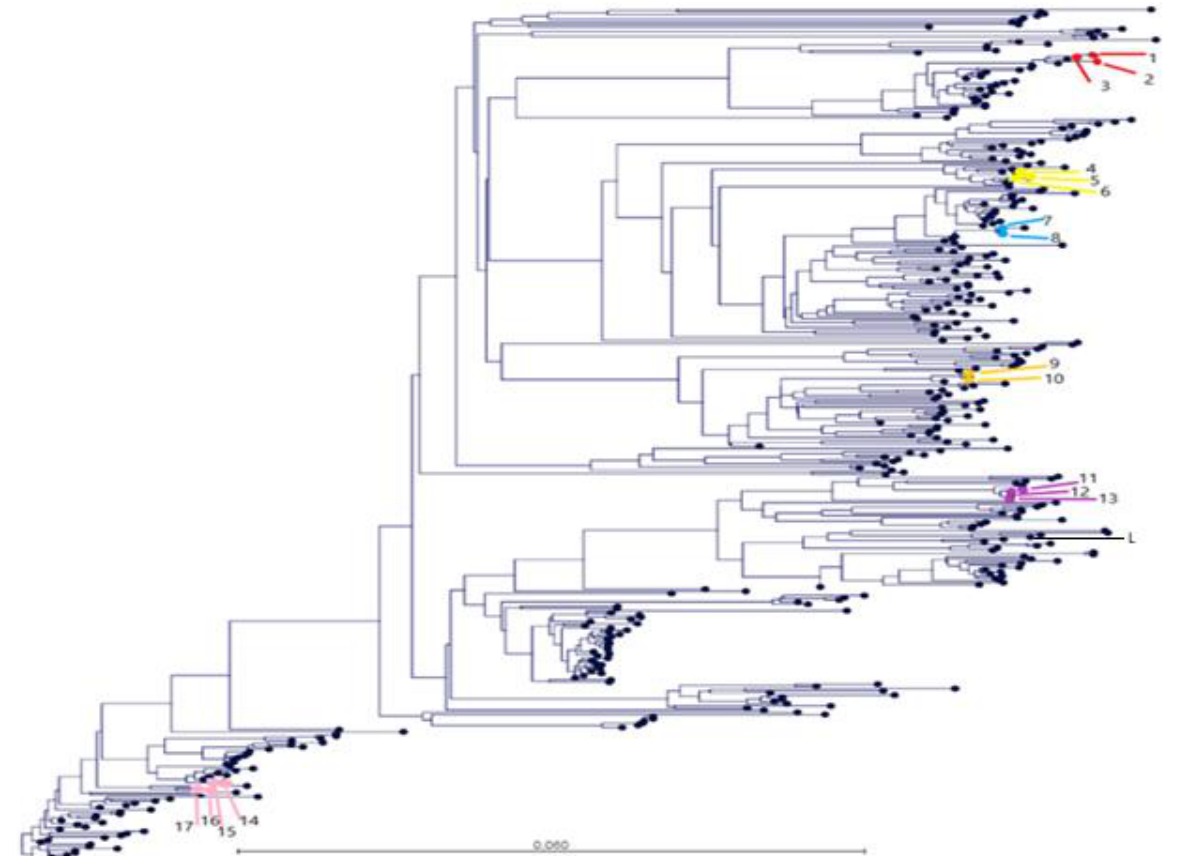
Figure 3. Phylogenetic tree of the Porcine Reproductive and Respiratory Syndrome virus (PRRSV) open reading frame 5 region (ORF5) of the different strains obtained from the Grup of Sanejament Porci (GSP) from serum samples between 2018 and 2020 and one reference strain (Lelystad PRRSV strain) available in GenBank (L in the figure). Some sequences coming from tongue exudate were also sequenced for farms 4, 50, 36, 6, 9, and 52 in this study. Samples coming from farms 4 (14,15, 16 ,17), 50 (1, 2 ,3), 36 (4,5, 6 ), 6 (7, 8 ), 9 (9, 10 ) and 52 ( 11 ,12,13) are represented in pink, red, light yellow, blue, dark yellow, and violet, respectively. The identification number of the sequences are detailed in brackets by farm and highlighted in bold if the origin is tongue exudate.